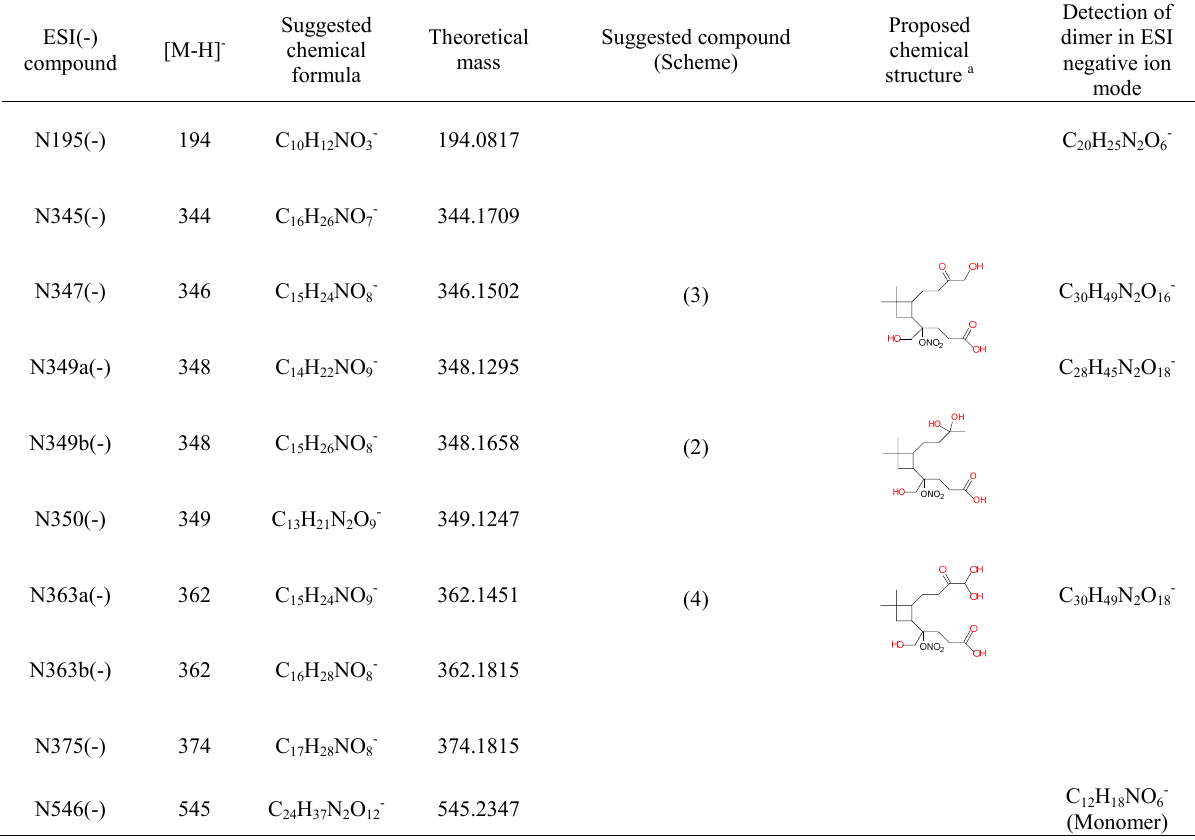
Table 4. Compounds detected by ESI in the negative ion mode in the series of β -caryophyllene/NO x irradiation experiments (Nitrogen- containing compounds).